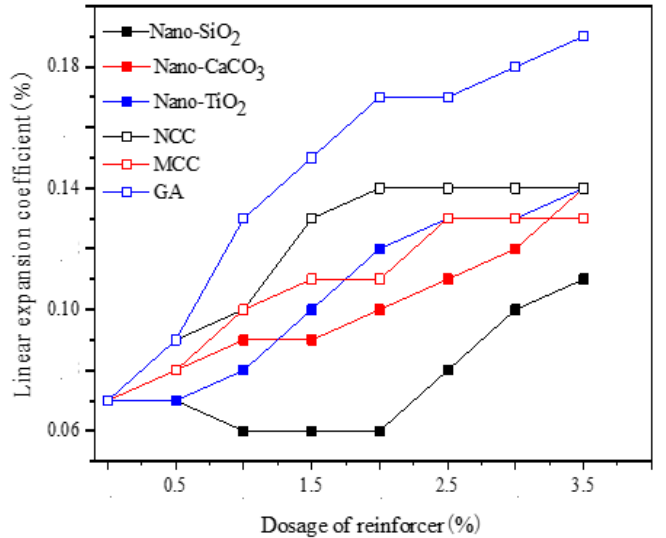
Figure 8. The effect of reinforcer on the linear expansion coefficient of α -hemihydrate gypsum at different dosages (ww −1 ).